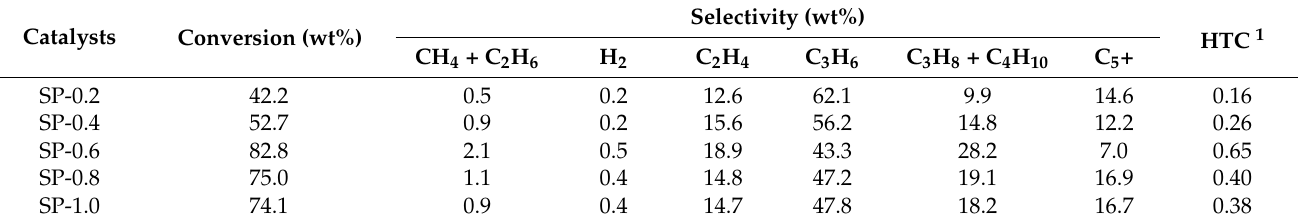
Table 4. Product distribution of 1-butene catalytic cracking over as-synthesized SAPO-34 samples.